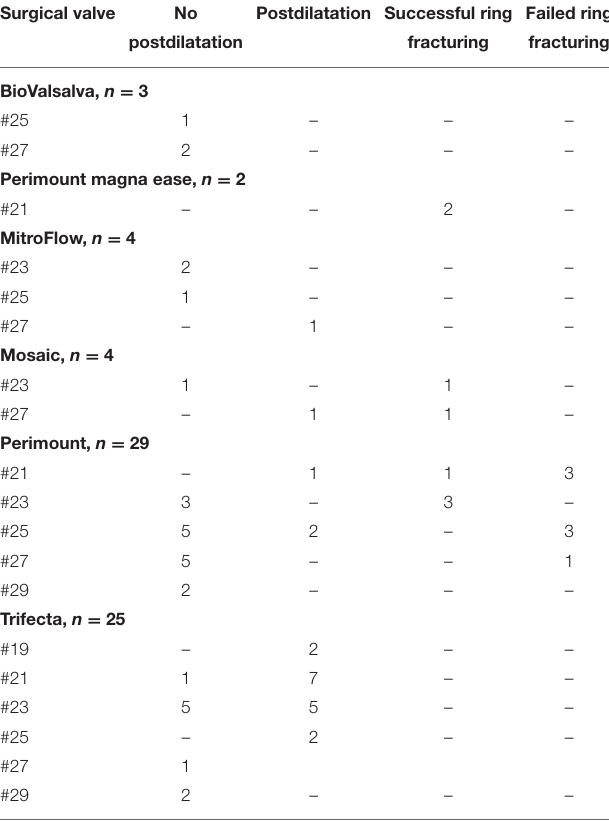
TABLE 3 | Failing surgical aortic valves treated with